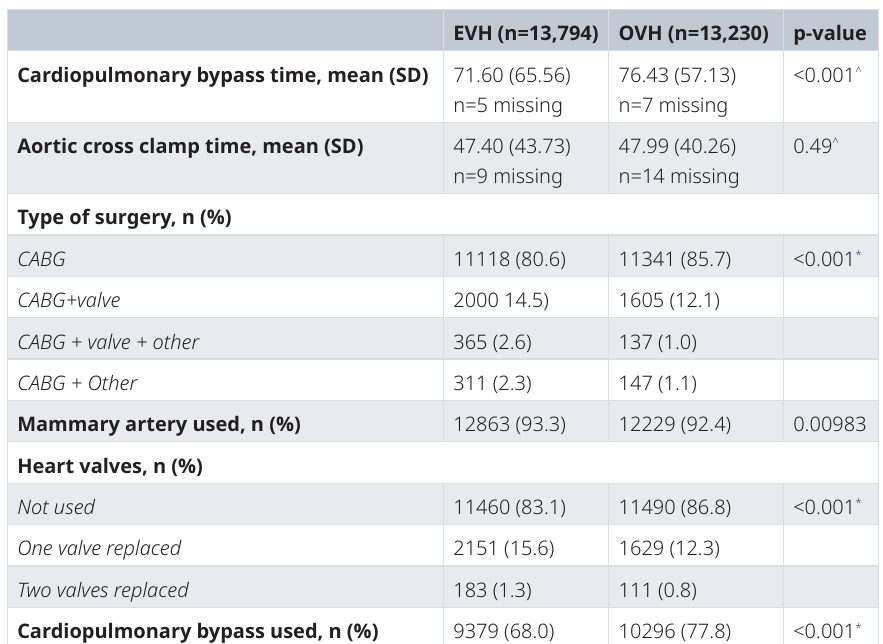
Table 2. Perioperative